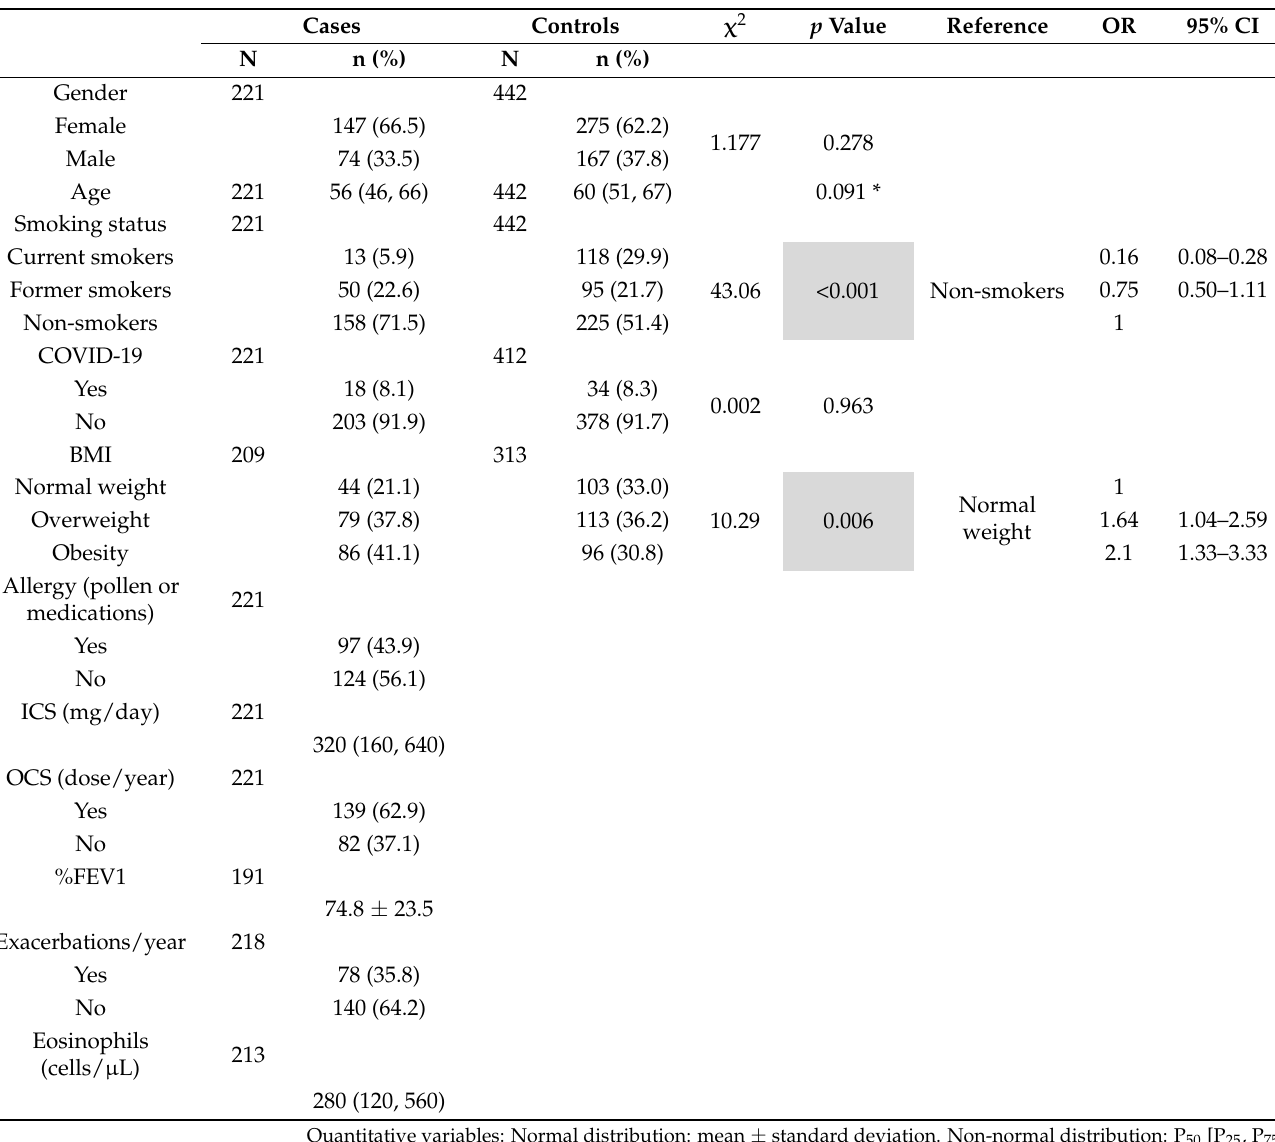
Table 2. Clinical-pathological characteristics of asthma cases and